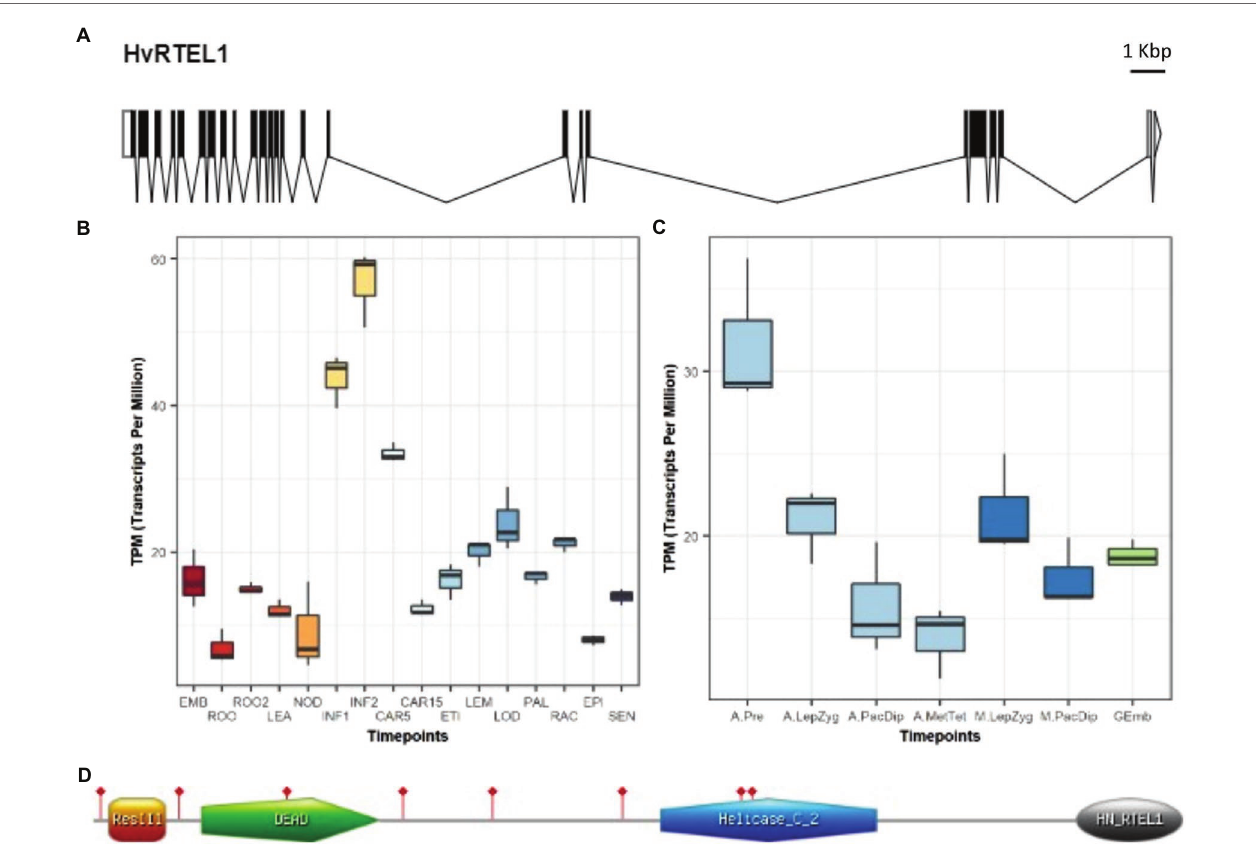
FIGURE 1 | Barley regulator of telomere elongation helicase 1 ( RTEL1 ) gene structure and expression. (A) Gene structure showing exons (black boxes), introns (black lines), and 5 ′ (white box) and 3 ′ (clear box and arrowhead) UTRs. (B) Expression levels in different parts and developmental stages of barley. The samples (three replicates each) are: EMB, 4-day embryos dissected from germinating grains; ROO, Roots from the seedlings (10 cm shoot stage); ROO2, Root (4 weeks); LEA, Shoots from the seedlings (10 cm shoot stage); NOD, Developing tillers at six leaf stage, 3rd internode; INF1, Young developing inflorescences (5 mm); INF2, Developing inflorescences (1–1.5 cm); CAR5, Developing grain, bracts removed (5 DPA); CAR15, Developing grain, bracts removed (15 DPA); ETI, Etiolated (10 day old seedling); LEM, Lemma (6 weeks PA); LOD, Lodicule (6 weeks PA); PAL, Palea (6 weeks PA); RAC, Rachis (5 weeks PA); EPI, Epidermis (4 weeks PA); and SEN, Senescing leaf (2 months). (C) Expression levels in barley anthers and meiocytes at different developmental stages. The samples (three replicates each) are: A.Pre, anther pre-meiosis; A.LepZyg, anther leptotene–zygotene; A.PacDip, anther pachytene–diplotene; A.MetTet, anther metaphase I–tetrad; M.LepZyg, meiocyte leptotene–zygotene; M.PacDip, meiocyte pachytene–diplotene, and Gemb, germinating embryos. The prefixes A., and M. in the sample names depict anther and meiocyte samples, respectively. (D) RTEL1 protein sequence (grey line) contains four conserved pfam domains (coloured shapes). The sites of eight conserved MEME motifs are flagged in